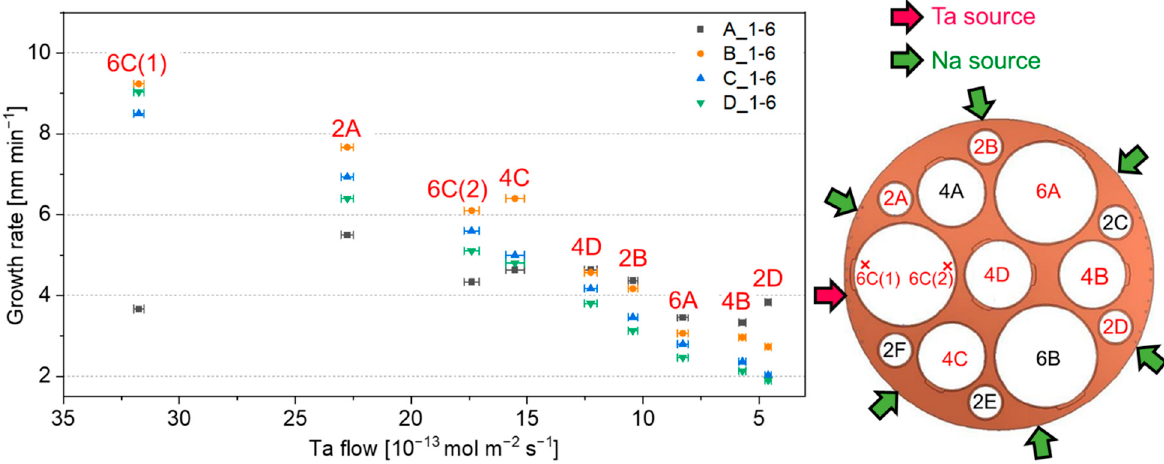
Figure 2. Measured average growth rate as function of the Ta flow calculated for each position of the samples in 1-6 batches. On the right, the schematic of the sample holder with the corresponding positions in red. The samples 6C(1) and 6C(2) come from the left edge and right edge, respectively, of the wafer 6C. The other samples come from the center of the respective wafers. Error bars refer to the Ta flows calculated at ± 5 mm away from the point where thickness measurements were performed, thus considering possible measurement errors related to the positioning of the sample.